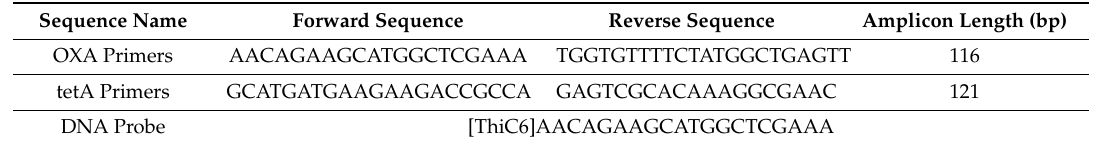
Table 1. DNA primer and probe sequences used in this